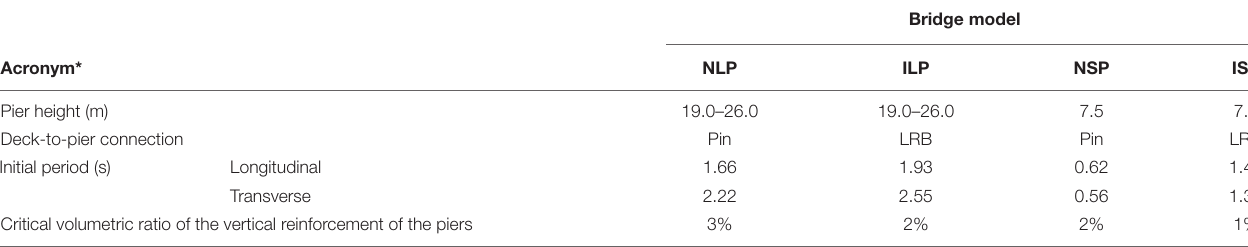
TABLE 1 | The most salient characteristics of different structural models studied in this